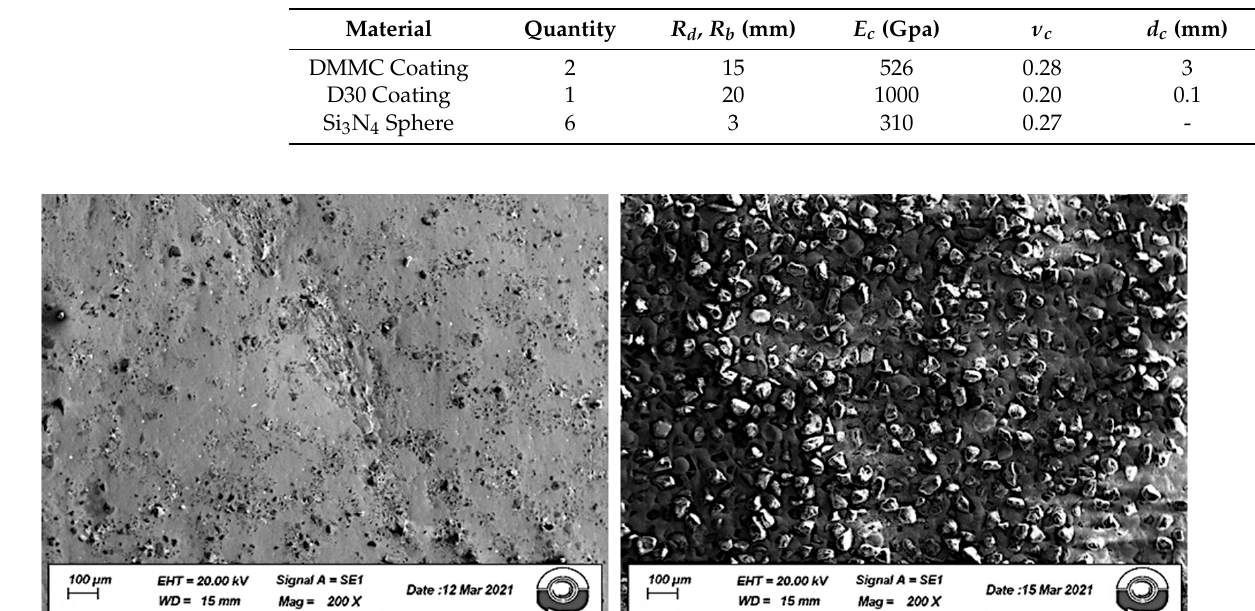
Figure 1. Samples for testing: ( a ) DMMC, ( b ) D30, and ( c ) Si 3 N 4 ball. Table 1. Sample dimensions and material physical properties of substrates and balls.